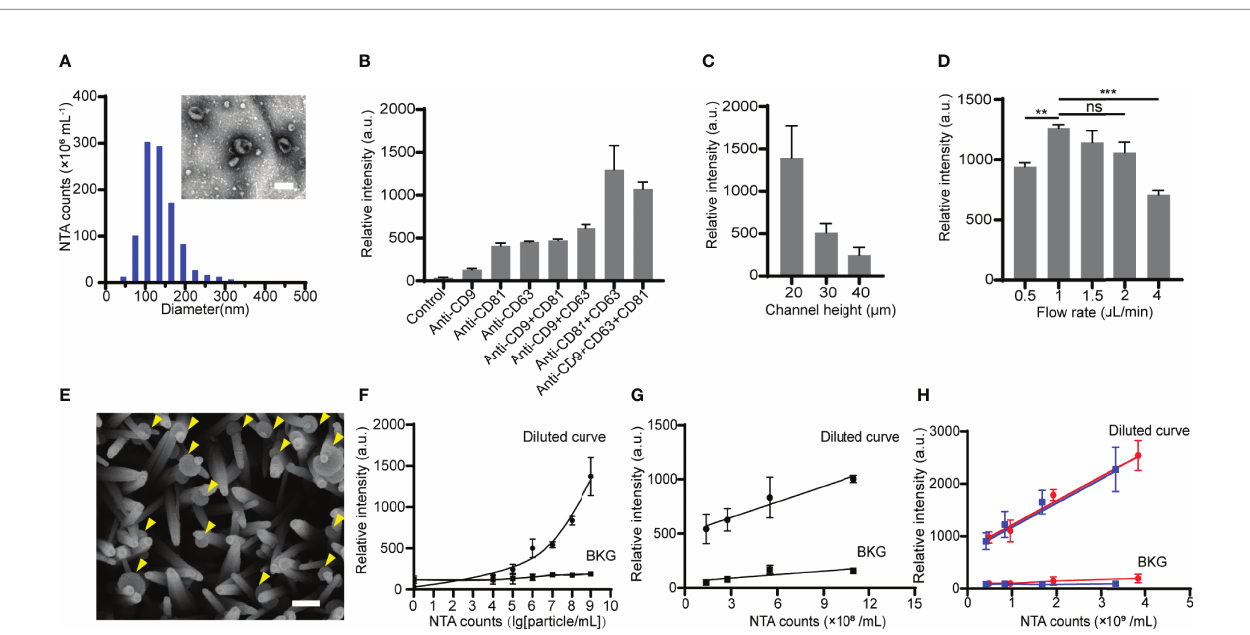
FIGURE 3 | Optimization of the ZNI chip for EV capture. (A) Transmission electron microscope photograph and nanoparticle tracking analysis (NTA) of HOS-derived EVs. Scale bar: 100nm. (B) The effect of various capture antibody combination modes on HOS-derived EV detection ef fi cacy. (C) The effect of various height of the main micro fl uidic channel of ZNI chip on HOS-derived EV detection ef fi cacy. (D) The effect of various fl ow velocities ranging from 0.5 m L/min to 4 m L/min on HOS-derived EV detection ef fi cacy. (E) Scanning electron microscope photographs of HOS-derived EVs captured by ZnO nanorods. Scale bar: 150nm. (F) Calibration curves for quantifying total HOS-derived EVs using ZNI chip under optimized function parameters. (G) Correlation of the EVs level between NTA and HOS-derived EVs resuspended in EV-free plasma. (H) Correlation of the EV level between NTA and patient-derived EVs resuspended in EV-deprived plasma using ZNI chip under optimized function parameters. BKG: background. Error bars correspond to the standard deviation (n = 3). ns: non-signi fi cant, p > 0.05, **p< 0.01, ***p < 0.001. “ Two-way repeated-measures ANOVA ” statistical analysis method was used to appraise the signi fi cance of different parameters as well as the batch effect in each experiment of (B – D)